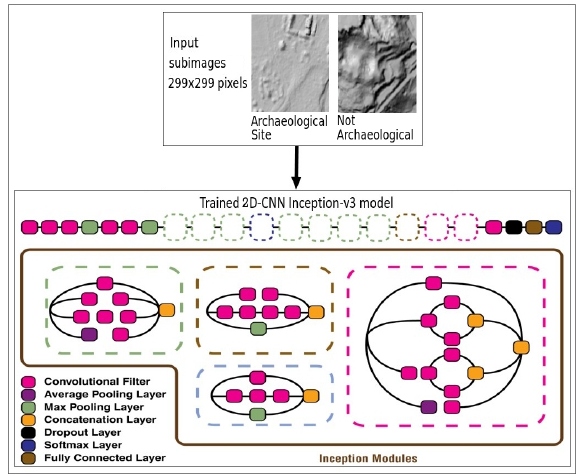
Figure 4. 2D-CNN Inception-v3 architecture is shown along with the 2D hillshade images used to train the